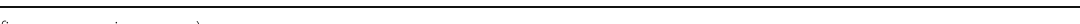
(See figure on previous page.) Fig. 7 57-year-old female presented by right uniparous spontaneous bloody discharge. a Mammogram showed one view asymmetry at outer part of right breast in CC view (white arrow) and partially obscured dense lesion (red arrow). b Ultrasound showed hypoechoic lesion with irregular margins (red arrow) and related dilated duct (white arrow) (BIRADS 5), referred for MRI to assess extent of the lesion. c Axial T1 showed irregular hypo- intense lesion (red arrow). d Axial STIR showed focal linear hyperintense signal (white arrows). e Axial dynamic THRIVE images showed irregular enhancing lesion (red arrow) previously seen in mammogram and ultrasound, associated with related suspicious linear non-mass enhancement matching with the linear focal asymmetry seen in CC view mammogram. (white arrows). f Type III curve of dynamic enhancement. g DWI showed